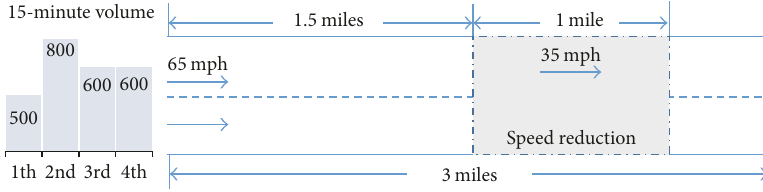
Figure 3: Proof-of-concept test network